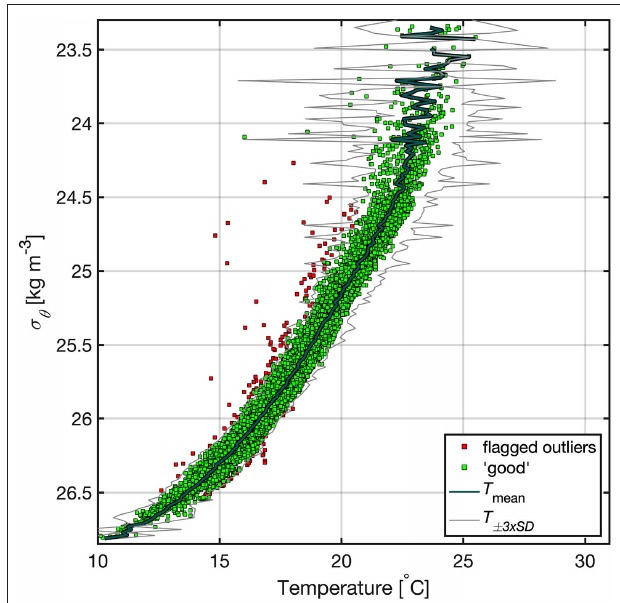
FIGURE 2 | Automatic outlier test. Bottle sample temperatures outside of the mean ± 3 × standard deviation lower and upper thresholds (“flagged outliers”) determined using the entire bottle record are compared with temperature within the upper and lower thresholds (“good”). The density-binned mean profile ( T mean ) and the ± 3 × density-binned standard deviation thresholds ( T ± 3xSD ) are also